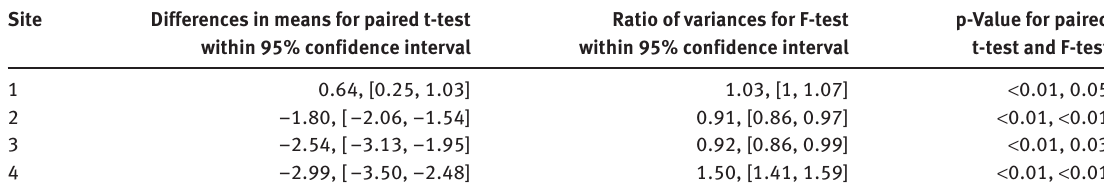
Table 8: Comparisons of Differences between Means and Variances Using Paired t-Test and F-test, p-Value with 95% Confidence Level at Different Sites for Trucks (C3) and Long Trucks and Buses (C4).